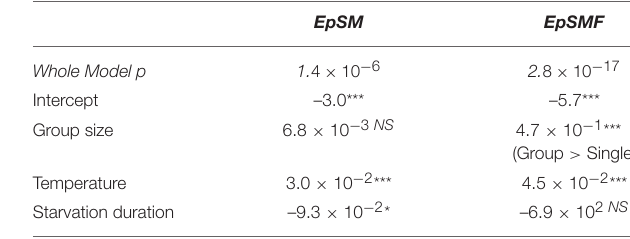
TABLE 1 | Results from generalized mixed models examining the effect of temperature and group size on two measures of feeding efficiency in Stegodyphus dumicola : fly mass extracted per unit spider mass over the duration of the experiment ( EpSM ) and fly mass extracted per unit spider mass per unit feeding time (10min) ( EpSMF